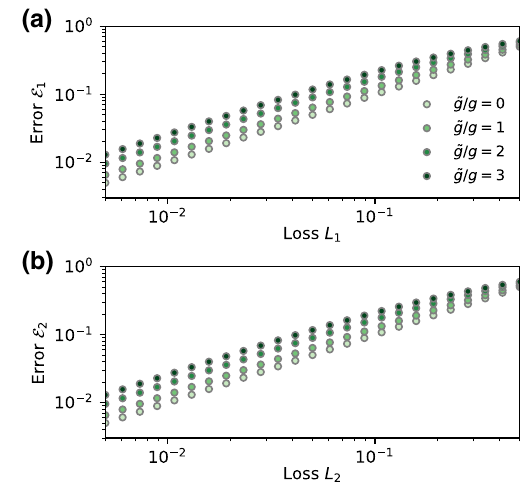
FIG. 6. Error induced by the loss of (a) the first squeezer and (b) the second squeezer for an extended PNR QND measurement with ˆ N eff = ˆ n a . For ˜ g / g = 1, 2,and 3, respectively, the required power gain G of the external squeezer is 3.8, 6.3, and 7.9